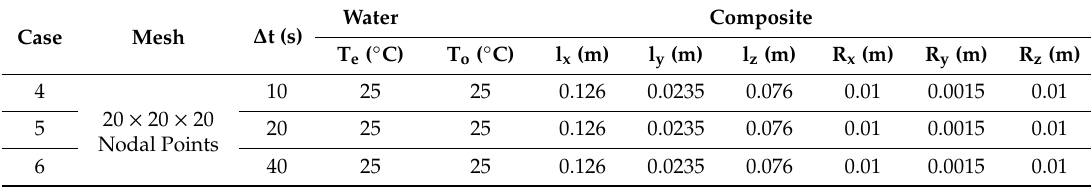
Table 2. Cases studied for selecting an appropriated time